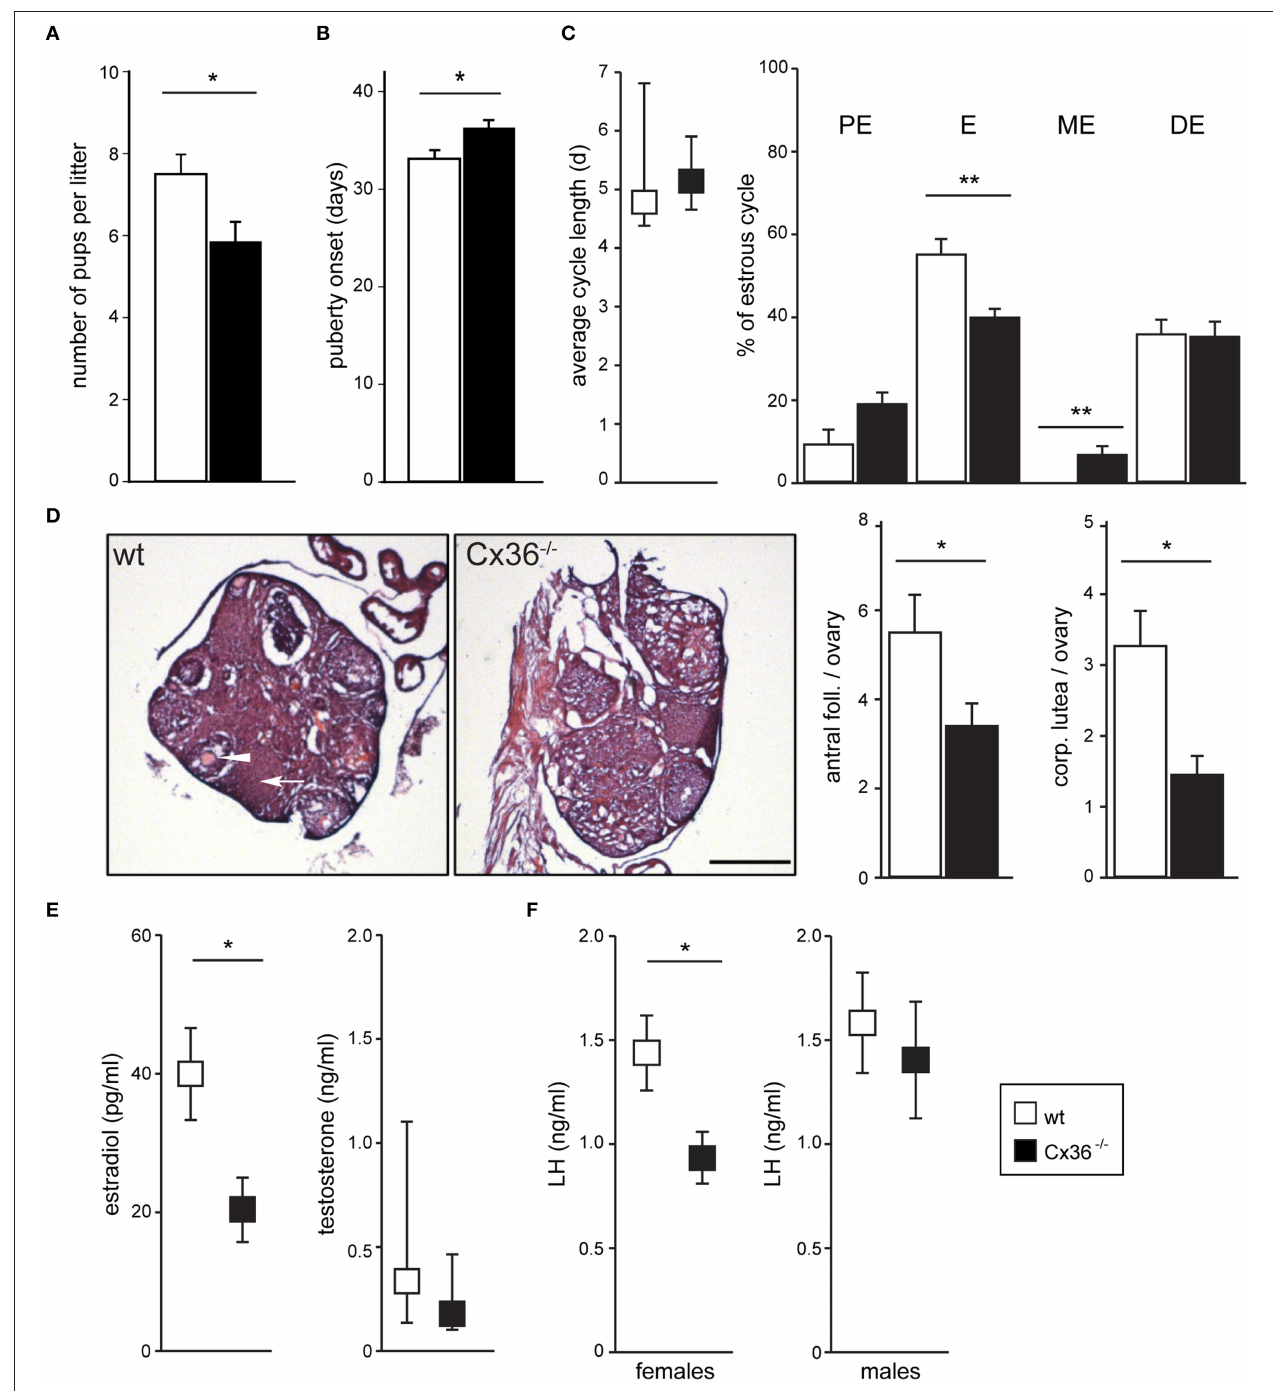
FIGURE 1 | Cx36 ablation affects the HPG axis downstream of the pituitary gland in a sex-specific fashion. (A) Cx36 − / − females produce smaller litters than wt females when mated with wt males. Wt females: n = 12 mice; Cx36 − / − females: n = 13 mice; Mean ± SEM; * P ≤ 0.05, Student’s t -test. (B) Puberty onset is delayed in Cx36 − / − females. Wt females: n = 17 mice; Cx36 − / − females: n = 15 mice; Mean ± SEM; * P ≤ 0.05, Student’s t -test. (C) Cx36 ablation differentially affects estrous cycle phases. The total duration of the estrous cycle was comparable in wt and Cx36 − / − females (left panel, n = 5 mice/genotype; median [IQR], Mann–Whitney U -test). However, while estrus duration was 55.04 ± 3.6% of the total cycle length in wt mice, it was reduced to 39.7 ± 1.98% in Cx36 − / − mice. Conversely, metestrus was on average 6.42 ± 1.9% of the total cycle time in Cx36 − / − mice, while this stage was too short to be detected in wt mice. Mean ± SEM. ** P ≤ 0.01, Student’s t -test, PE, proestrus; E, estrus; ME, metestrus; DE, diestrus. (D) Ovaries in Cx36 − / − mice exhibit histological alterations. Representative images of hematoxylin and eosin stained sections from wt and Cx36 − / − ovaries. Averaged number of antral follicles and of corpora lutea per ovary at the first day of estrus